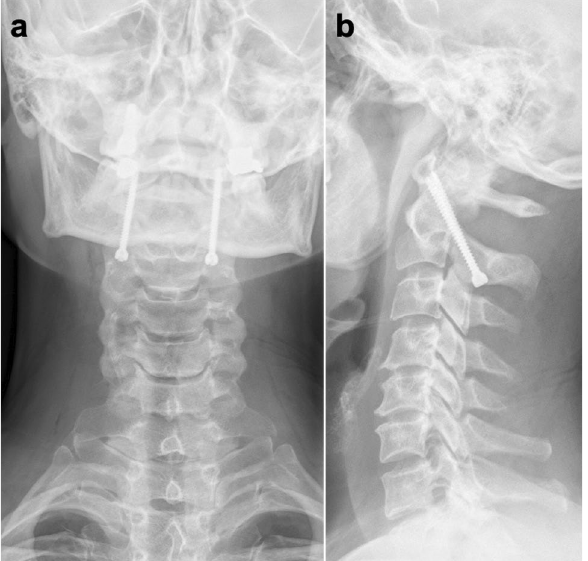
Figure 4. Correct screw position. This figure shows a typical example of a correct material position after isolated percutaneous transarticular screw fixation of C1 and C2 (IPTSFC1/C2). Conventional X-ray. ( a ) Anterioposterior plane. The screws inserted bridge the atlantoaxial joints on both sides and pass thrue the lateral mass of C1 and C2 on both sides. ( b ) Sagittal plane. The screws do not protrude more than 5 mm beyond the anterior arch of C1. If all these criteria match, the position of the screw is considered to be